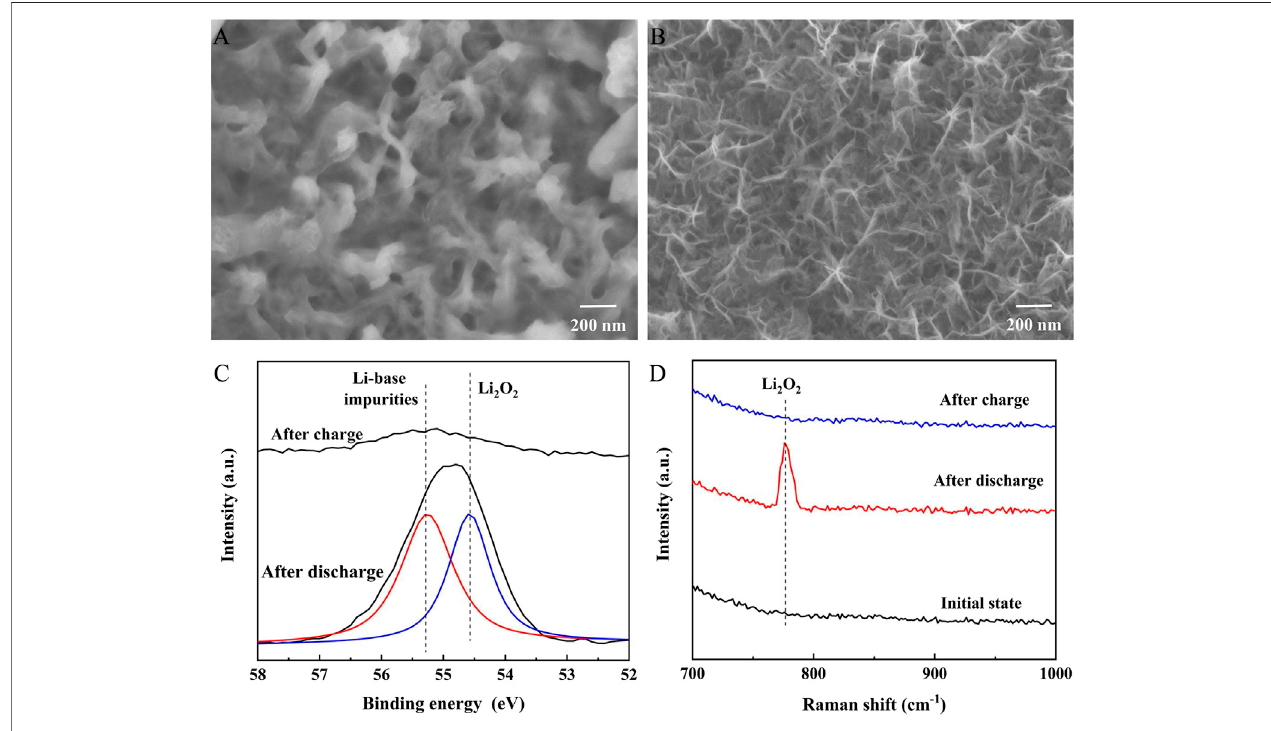
FIGURE 5 | Characterizations of the discharge products on Cr 2 O 3 /MnO 2-x : (A) , (B) morphology of the Cr 2 O 3 /MnO 2-x electrode after discharge and charge; (C) Li 1s spectra of the Cr 2 O 3 /MnO 2-x electrode after discharge and charge; (D) Raman spectra of the Cr 2 O 3 /MnO 2-x electrode after discharge and charge.